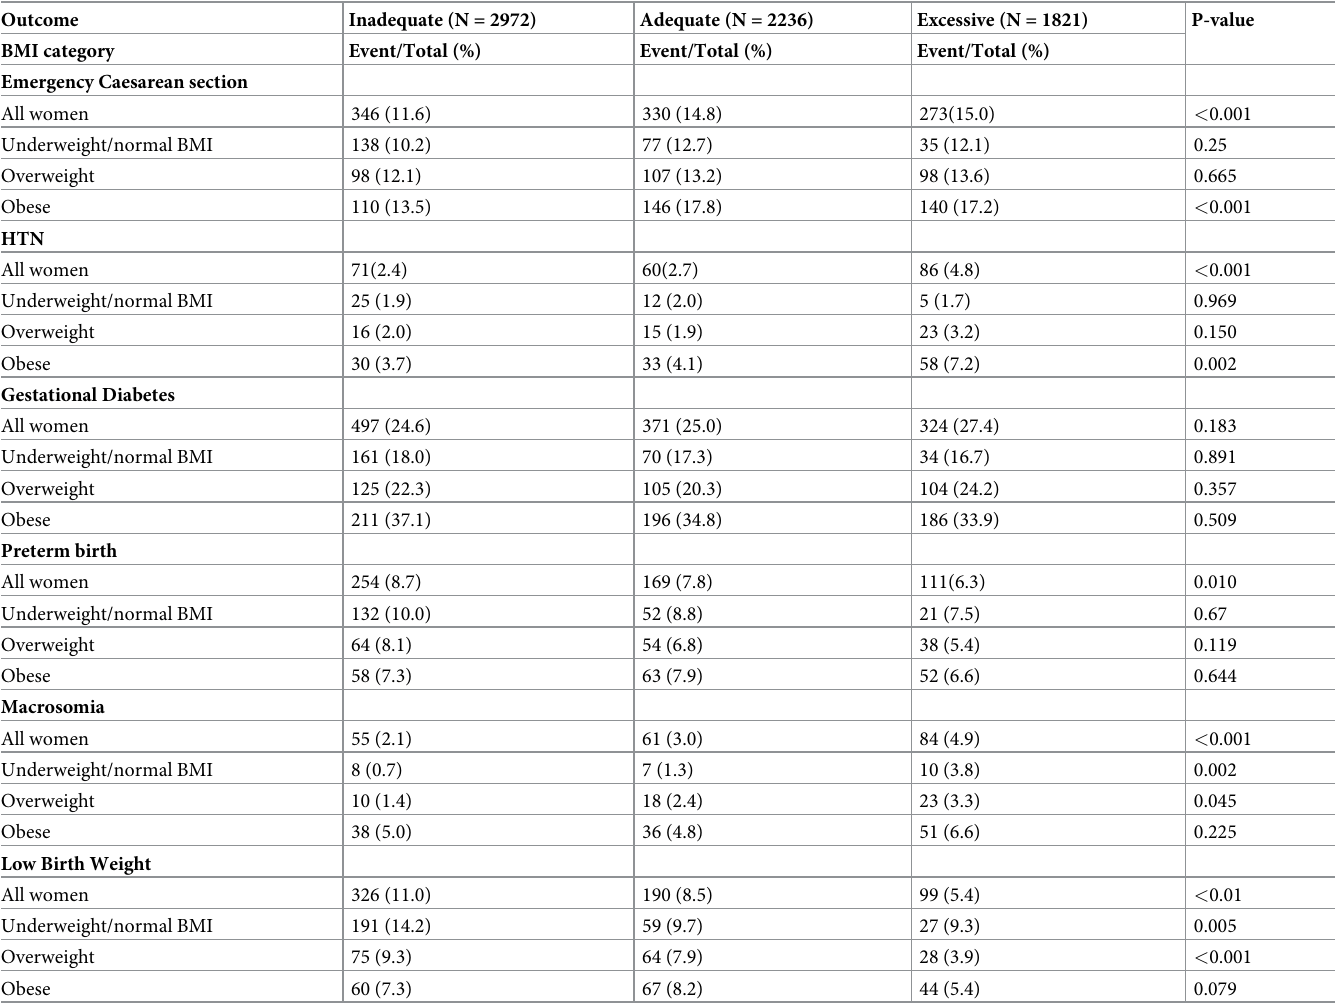
Table 2. Association of pregnancy outcomes with gestational weight gain among participants according to the prepregnancy body mass